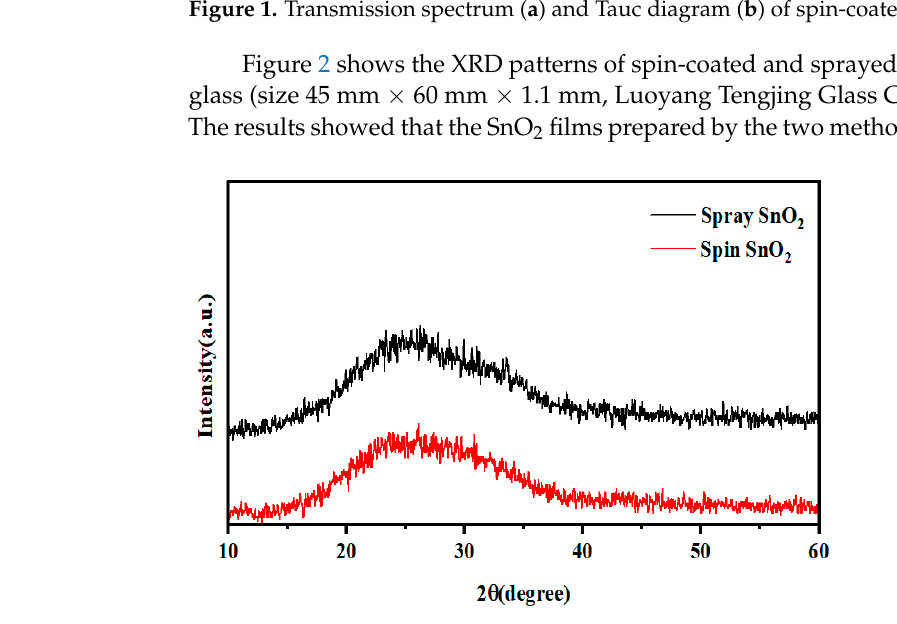
Figure 1. Transmission spectrum ( a ) and Tauc diagram ( b ) of spin-coated and sprayed SnO 2 films.